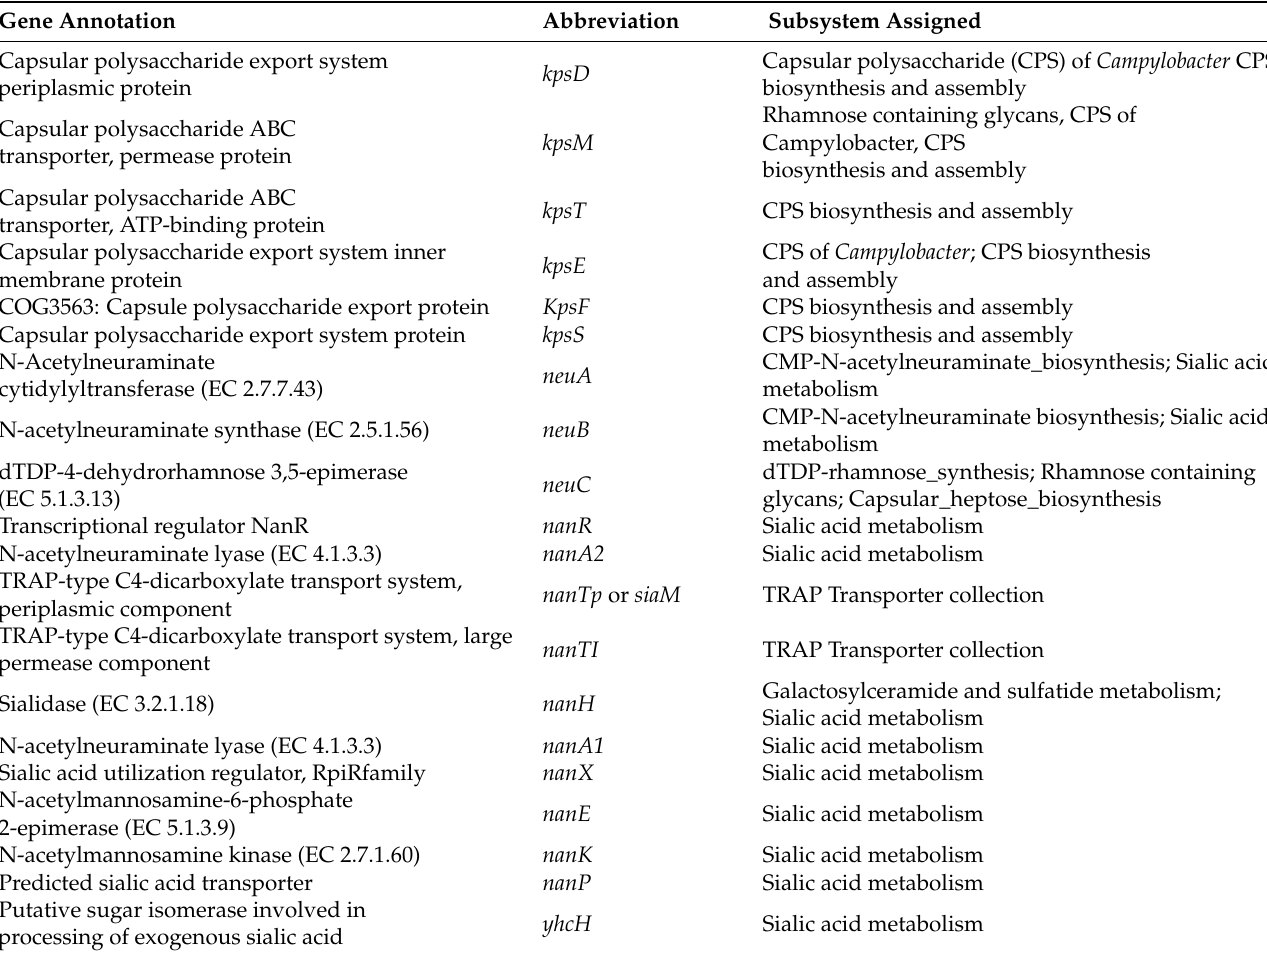
Table 2. Gene annotation of the polysaccharide (polysialic acid) capsular and sialic acid